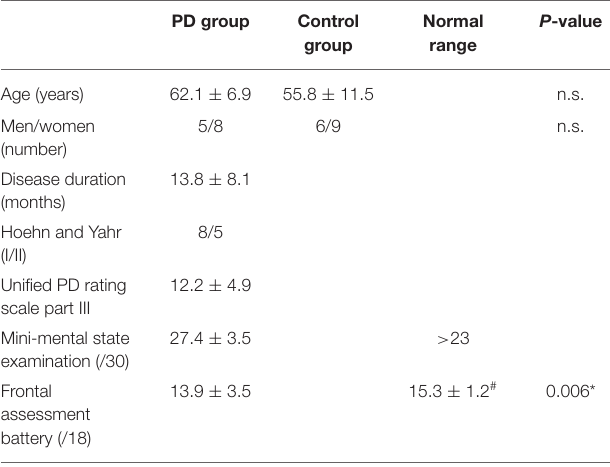
TABLE 1 | Demographic and clinical characteristics of participants in the Parkinson’s disease (PD) group and control